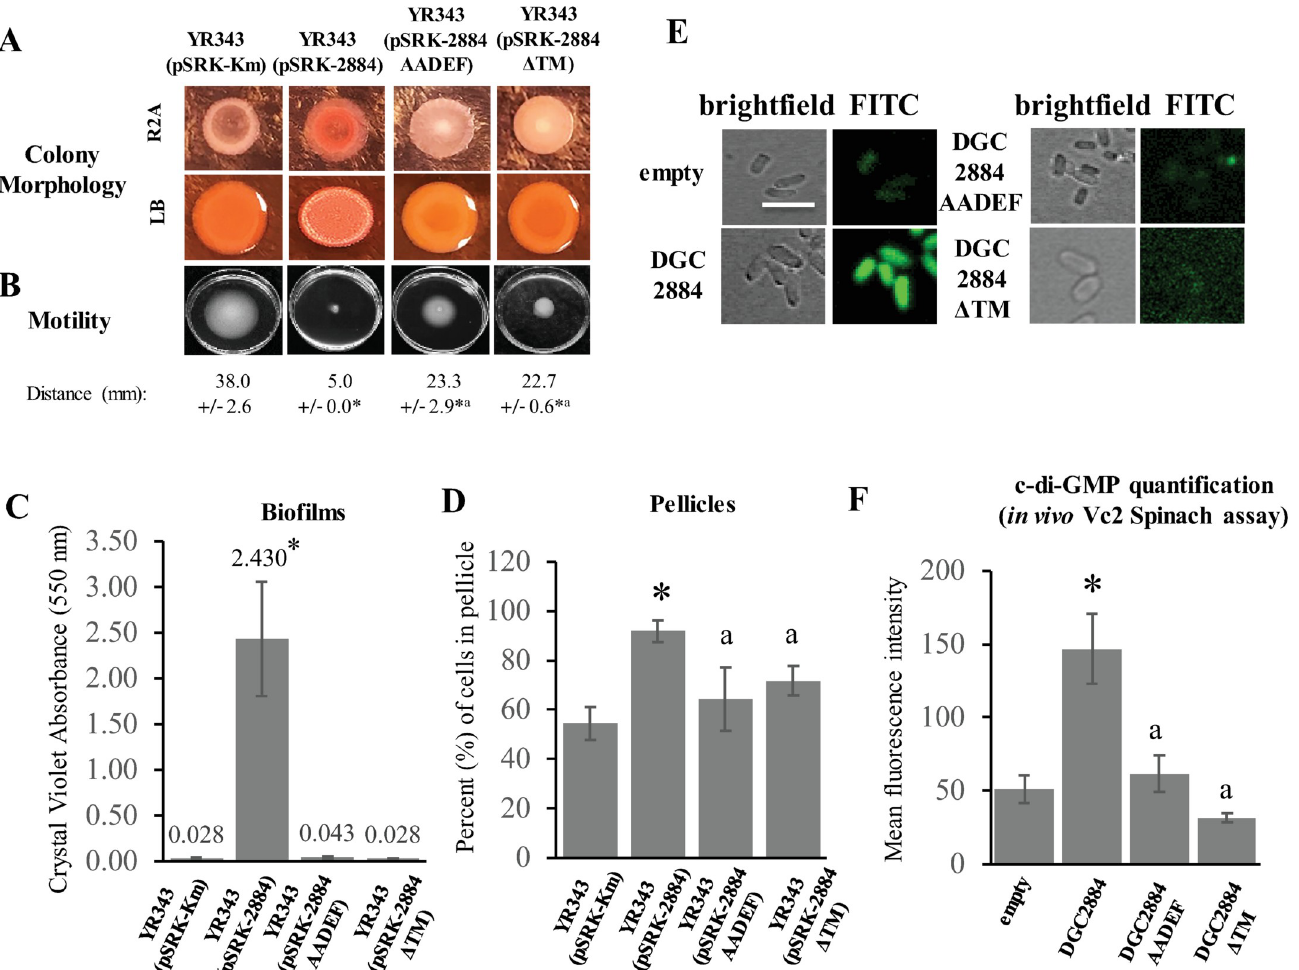
Fig 2. Characterization of individual diguanylate cyclases expressed in a wild type Pantoea sp. YR343 background. (A) Indicated strains were spotted on either LB or R2A media containing Congo Red for 48 hours prior to imaging. Each plate consisted of three replicates and experiments were repeated at least three times. (B) Swim agar plates were inoculated in the center of each plate and incubated for 24 hours prior to imaging. Average swimming ring diameter was determined from three individual experiments consisting of three biological replicates each. ( � ) indicate statistically significant differences (p � 0.001) compared to the wild type strain harboring an empty vector and ( a ) represents statistically significant differences (p � 0.001) compared to the strain overexpressing DGC2884, both of which were measured by the student’s t-test. ANOVA analysis also showed significant differences between samples with a p-value � 0.001. (C) Indicated strains were grown under conditions conducive to biofilm formation on vinyl coverslips for 72 hours prior to staining with Crystal Violet. Average absorbance values at 550 nm for each sample are shown in graph. Data is representative of at least three independent experiments consisting of at least 3 biological replicates per sample each time. ( � ) indicate statistically significant differences (p < 0.005) as measured by the student’s t-test when compared to the wild type strain with the empty vector. ( a ) represents a statistically significant difference (p < 0.001) when compared to overexpression of DGC2884 as measured by the student’s t-test. ANOVA statistical analysis also showed significant differences between samples (p � 0.001). (D) Pellicle formation assays were used to compare the percentages of cells in pellicles for each sample after a period of 72 hours. Each bar represents three biological replicates from a single experiment. Experiment was performed twice with similar results. ( � ) indicate statistically significant differences (p = 0.002) compared to the wild type strain possessing an empty vector and (a) represents a statistically significant difference (p = 0.012 for DGC2884 AADEF; p = 0.004 for DGC2884 Δ TM) compared to the strain overexpressing DGC2884, both of which were measured by the student’s t-test. ANOVA analysis showed a p-value of 0.007 between groups in this experiment. (E) Fluorescence micrographs of representative cells co-expressing the Vc2 Spinach aptamer with the indicated constructs. Scale bar represents 5 μ m. (F) Diguanylate cyclase enzyme activity is shown as a bar graph comparing the mean fluorescence intensity measured across 50 cells per sample. Error bars represent the S.E.M. values. ( � ) indicate statistically significant differences (p < 0.001) as measured by the student’s t-test. ANOVA analysis showed significant differences between groups (p � 0.001). Data shown represents three separate